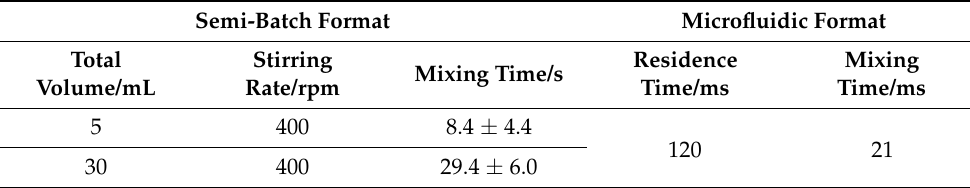
Table 1. Mixing characteristics of the semi-batch system with increasing total volume, measured using the DISMT method, and the estimated mixing properties in microfluidic format . As the volumetric scale increased in semi-batch format, the bulk mixing time increased while the micro-mixing time was unaffected by microfluidic chip parallelization. Semi-Batch Format Microfluidic Format Total Stirring Residence Mixing Mixing Time/s Volume/mL Rate/rpm Time/ms Time/ms 5 400 8.4 ± 4.4 120 21 30 400 29.4 ±